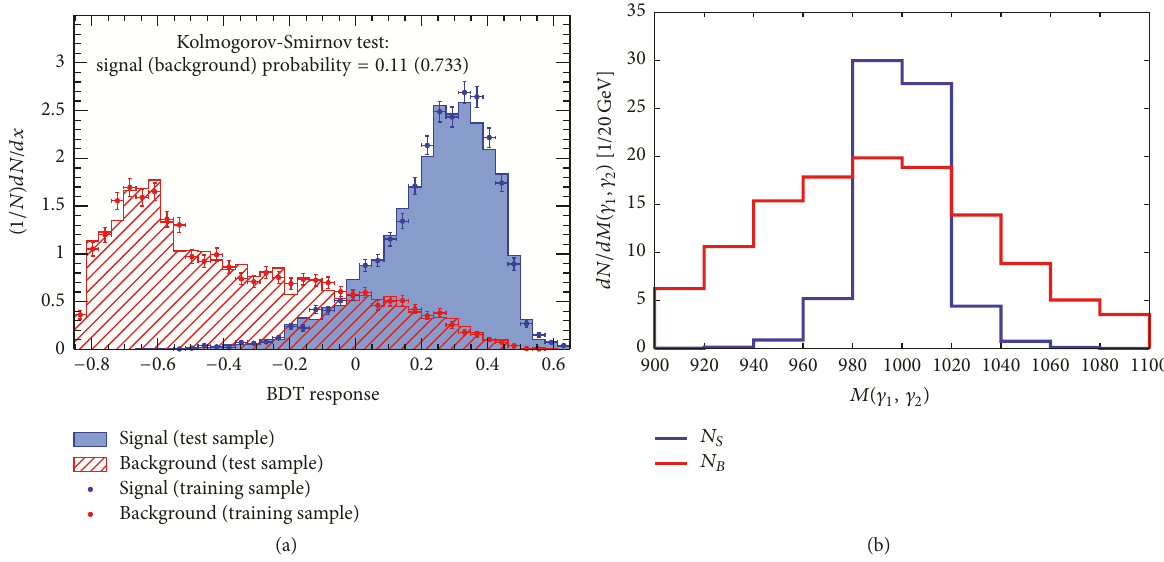
Figure 6: (a) BDT response of the signal (blue) and the background (red) for 𝑀 S = 1 TeV. (b) 𝑀(𝛾 1 ,𝛾 2 ) distributions for the signal (blue) and the background (red) for 𝑀 S = 1 TeV after applying the optimal BDT cut at ∼ 0 to obtain 5𝜎 significance at the 13TeV LHC with L = 300 fb −1